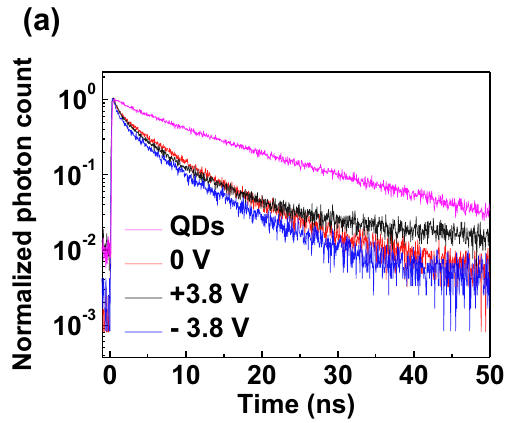
Figure 5. ( a ) Time-resolved photoluminescence decay results of QDs on quartz and full devices with zero bias, light-emitting mode (+ 3.8 V) and light-detecting mode (− 3.8 V), respectively.